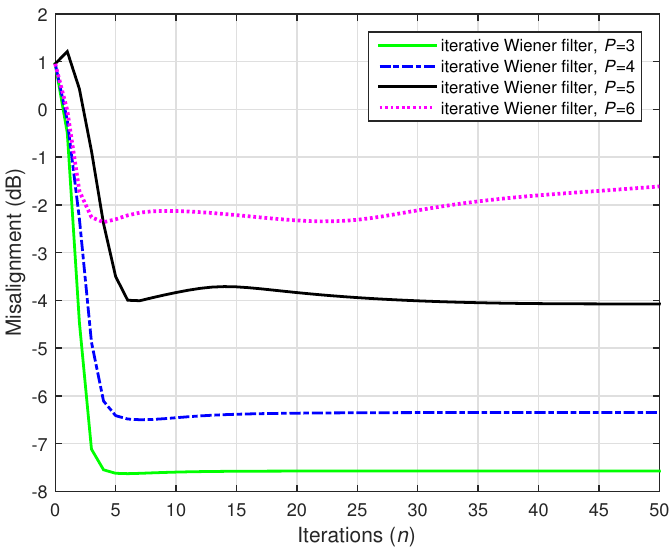
Figure 15. Performance of the iterative Wiener filter with different values of P , using N = 1500. The input signals were independent AR(1) processes, M = 4, L = 500, and SNR = 10 dB.